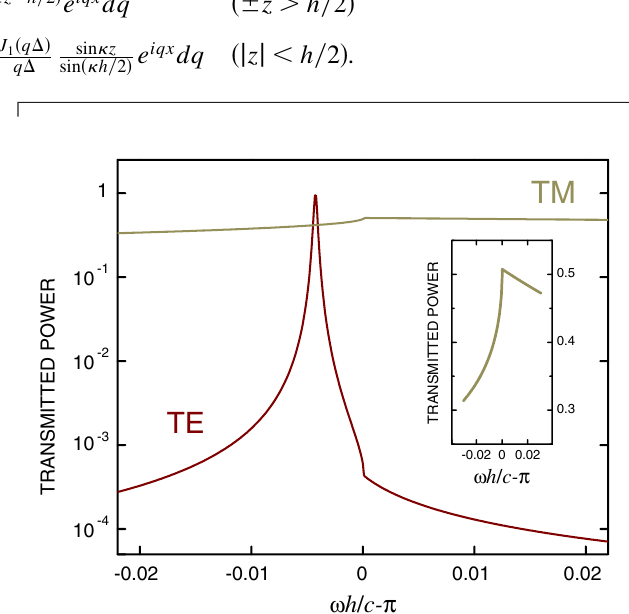
FIG. 4. Log plot of the transmitted power, normalized to the value corresponding to perfect transmission, as a function of the frequency. The data are for (cid:2) ¼ h= 10 . Results reported in [22] were used to get the TM curve. A linear plot for the TM geometry is shown in the